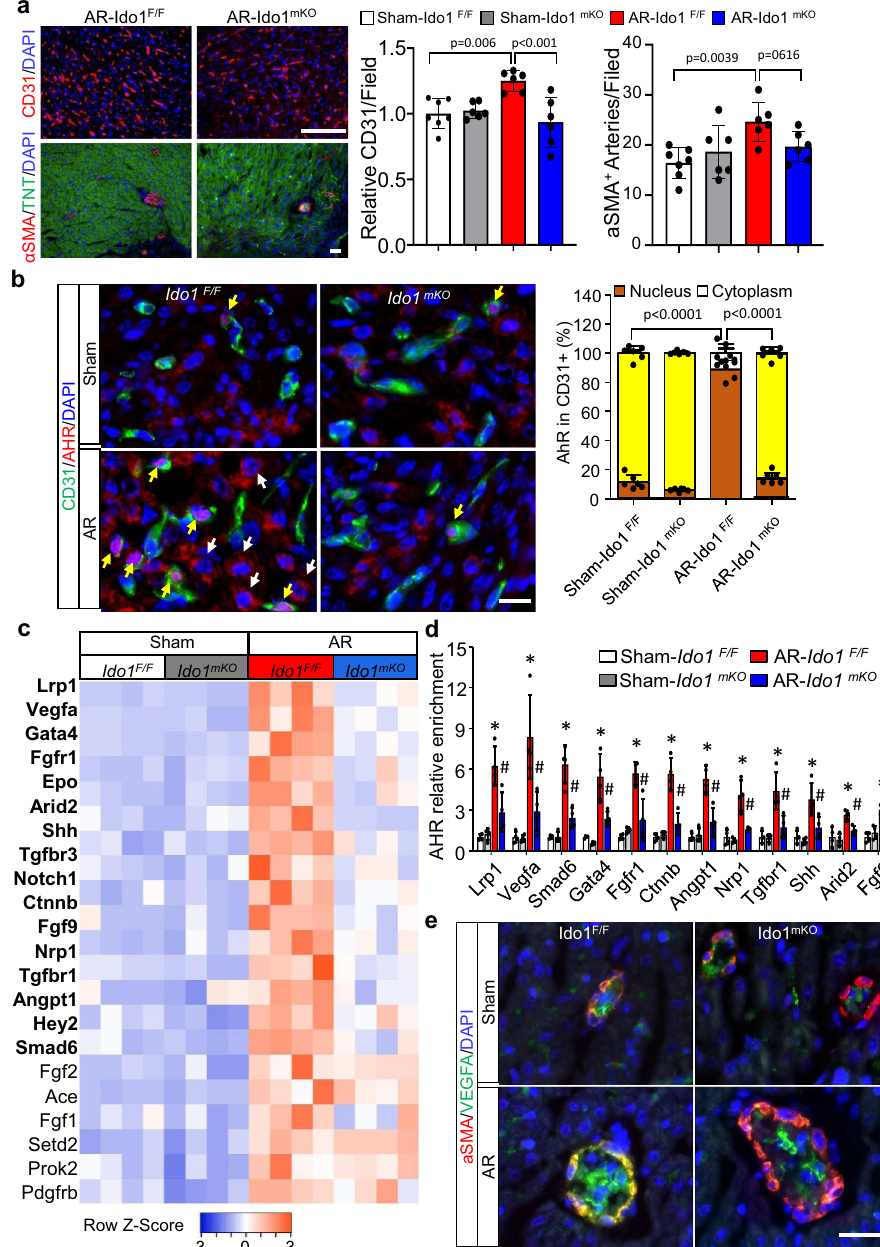
Fig. 4 | Kyn-activated AhR promotes cardiac angiogenesis in cardiac regen- eration. Ido1 F/F ( Ido1 Flox/Flox )and Ido1 mKO ( Tnt Cre ; Ido1 Flox/Flox )miceunderwentheartAR or Sham surgery at P1 and were collected at P7 for cardiac angiogenesis study. a Representative images and quanti fi cation of CD31 (endothelial cell-speci fi c mar- ker) and α -SMA (smooth muscle cell-speci fi c marker) immuno fl uorescence (IF) staining ( n =7 for Sham- Ido1 F/F group; n =6 for other three groups). Bar=100 µ m. b Co-IF staining and quanti fi cation of the location of AHR at cytoplasm (white arrow) and nucleus (yellow arrow) in CD31-positive cells ( n =7 for Sham- Ido1 F/F group; n =6forotherthreegroups).Bar=20 µ m.Two-wayANOVAfollowed bythe Tukey ’ s test was used for statistical analysis. c Heatmap showing all signi fi